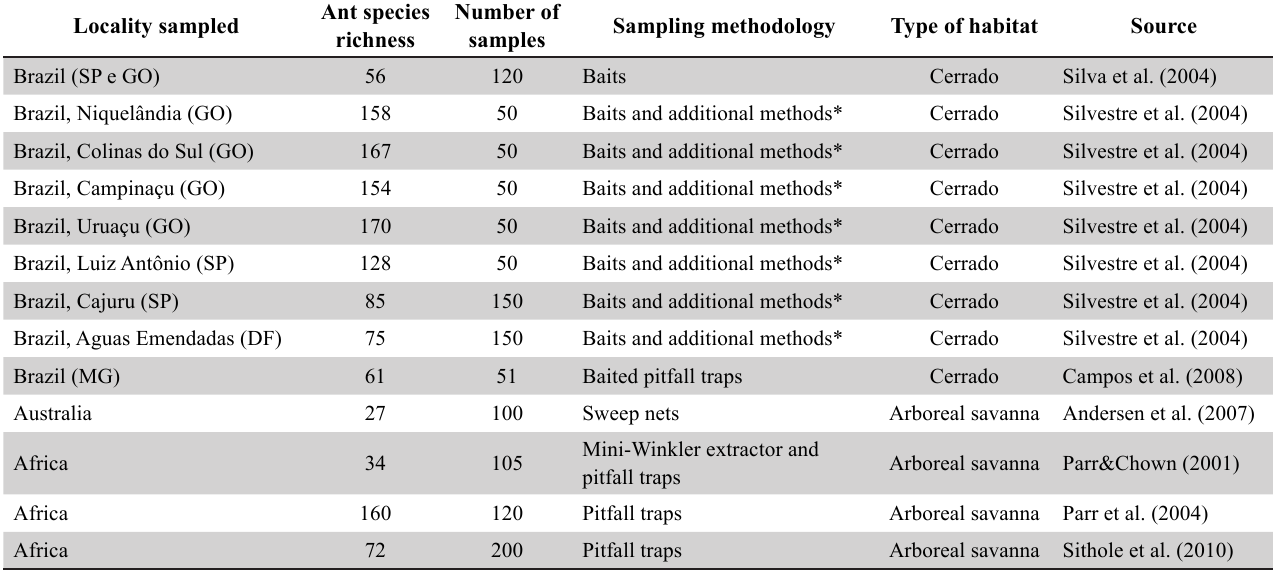
Table 2 . Number of ant species recorded in different tropical savannas areas of the world. Locality